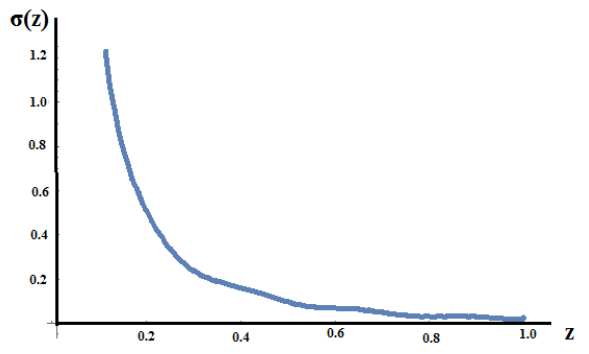
The stress function Σ ( z ), applied in the Λ -space, is expressed in the variable z in the initial space. The distribution of the axial stress function Σ ( z ) in the initial space is shown in Figure 18.